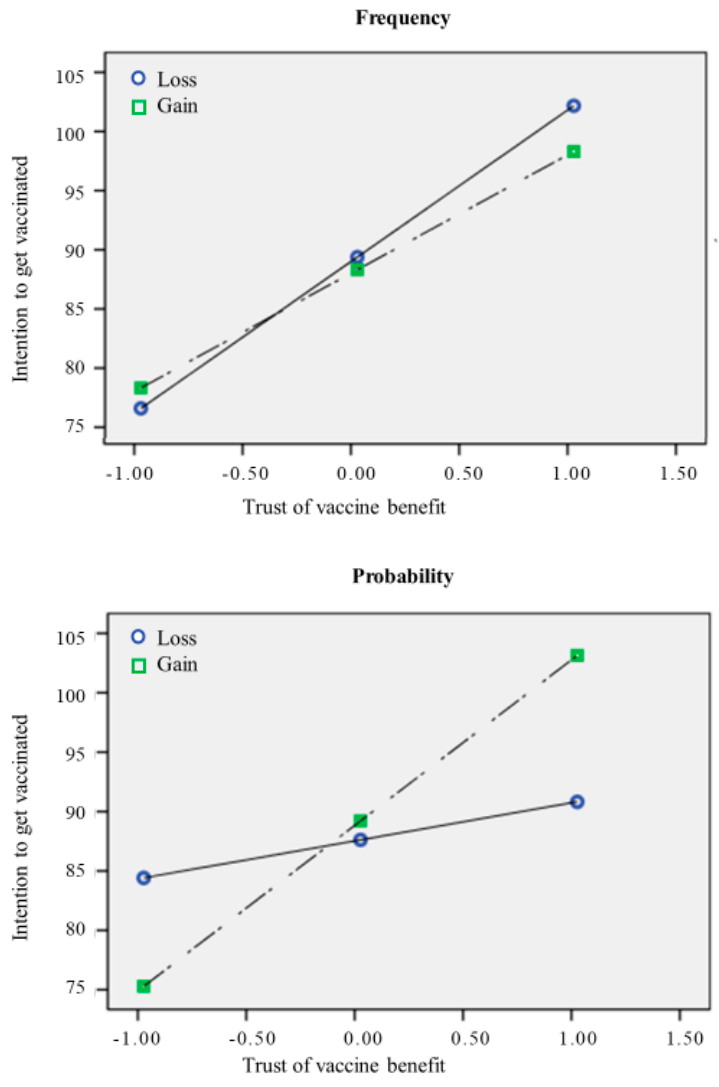
Figure 2. The relationship between trust in vaccine benefit and intention to get the vaccine.